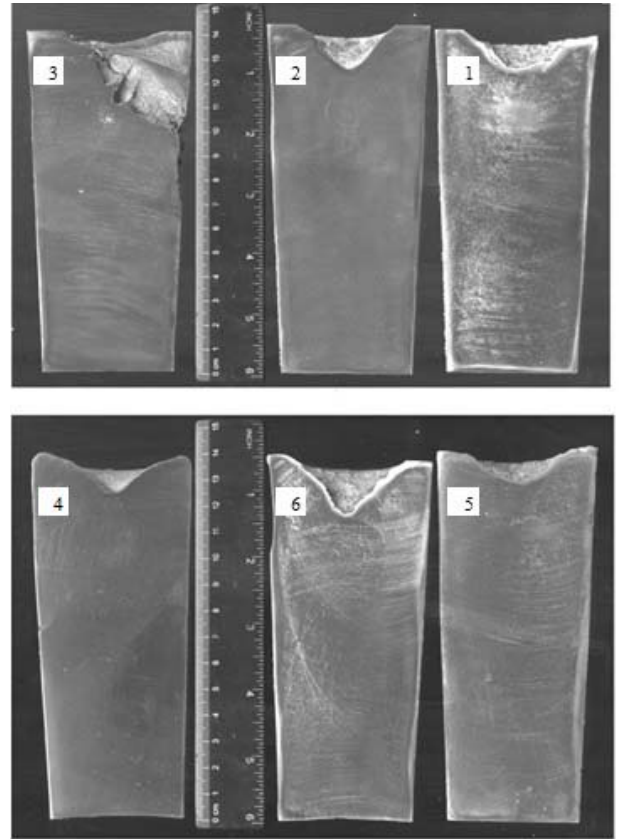
Figure 6. Macrostructures of 356 ingots: 1—after vibration by 100 Hz; 2—after vibration by 150 Hz; 3—after vibration by 200 Hz; 4—after modification by ultrafine powder modifier; 5—after modification by ultrafine powder modifier followed by 100 Hz vibration; 6—after modification by ultrafine powder modifier followed by 150 Hz vibration.